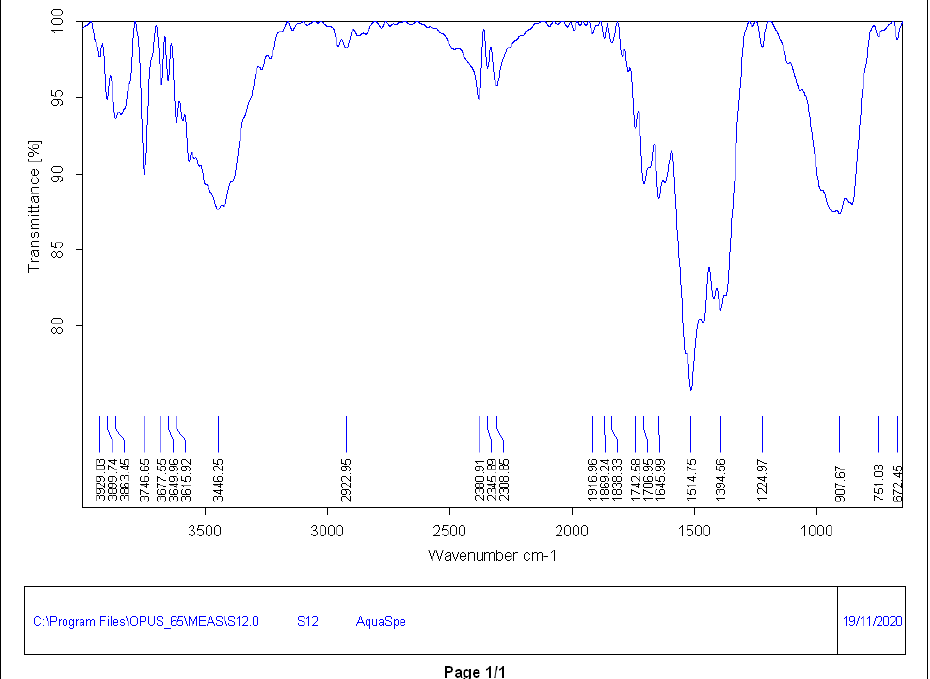
Fig. 3. FT-IR spectra of Sm 2 O 3 NPs